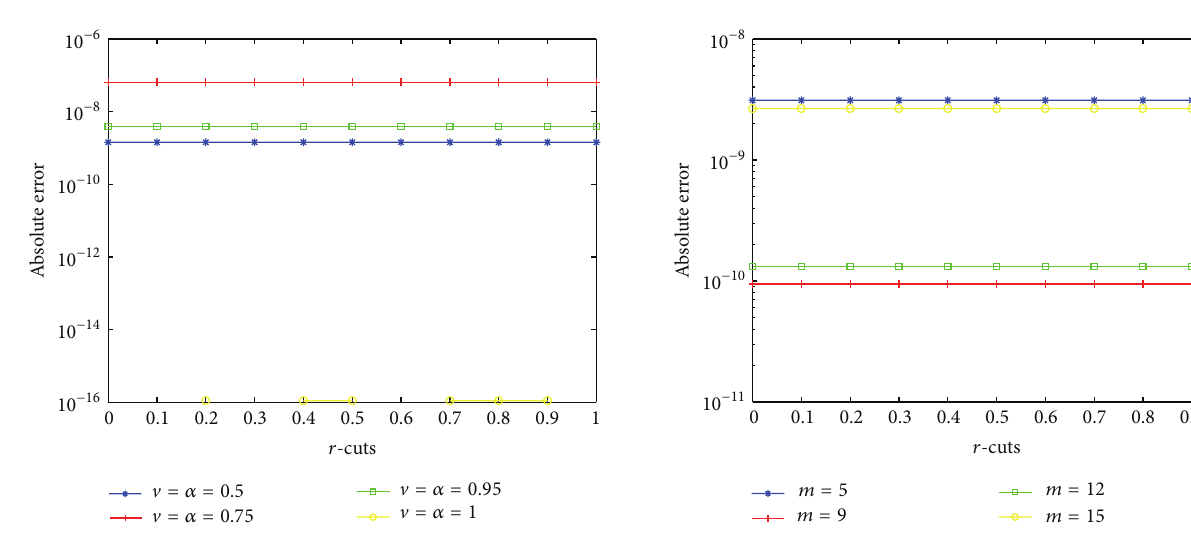
Figure 13: The absolute error for different values 𝑚 with V = 𝛼 = = 0.05 , and 𝑘 = 0.05 0.95 , 𝑘 1 2